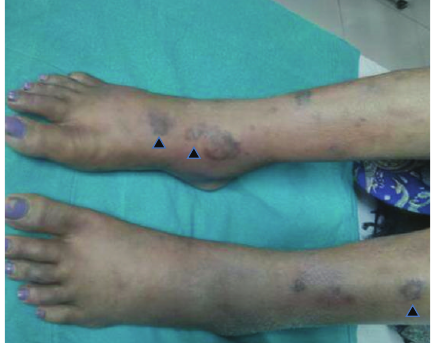
Figure 3: Picture of legs showing papules and nodules on dorsum of legs, necrotic lesions with irregular borders over lower leg and feet, and dorsal tenosynovitis of both feet (black